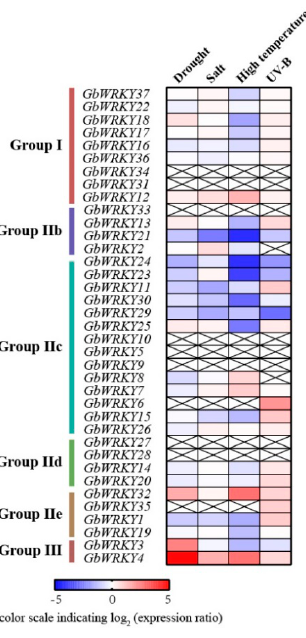
Figure 5. The number of cis − acting elements was tested in the promoter region of GbWRKYs. The name of cis − acting elements was listed on the left side of the image, and the corresponding function annotation was listed on the right side.